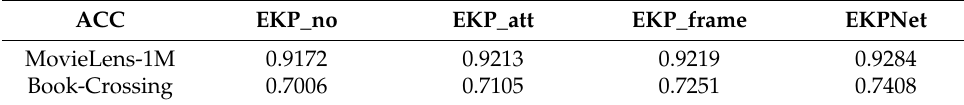
Table 4. The performance of different variants in the CRT prediction scenario.